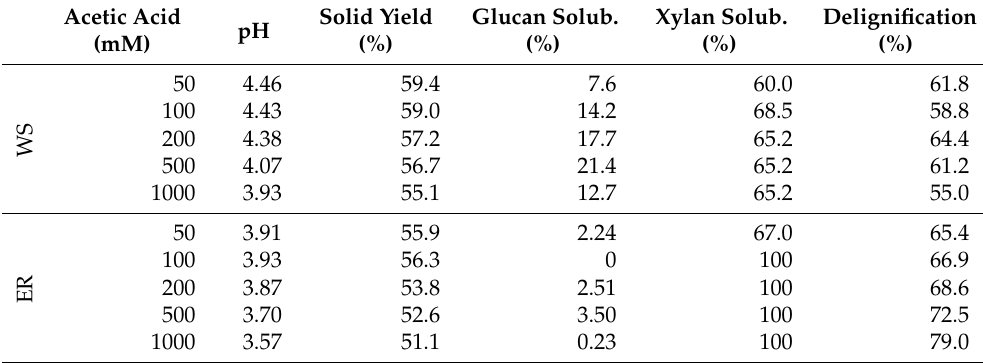
Table 3. Fractionation of wheat straw (WS) and eucalyptus residues (ER) biomass using ethanol-based organosolv process (acetic acid added catalyst, 190 ◦ C, 120